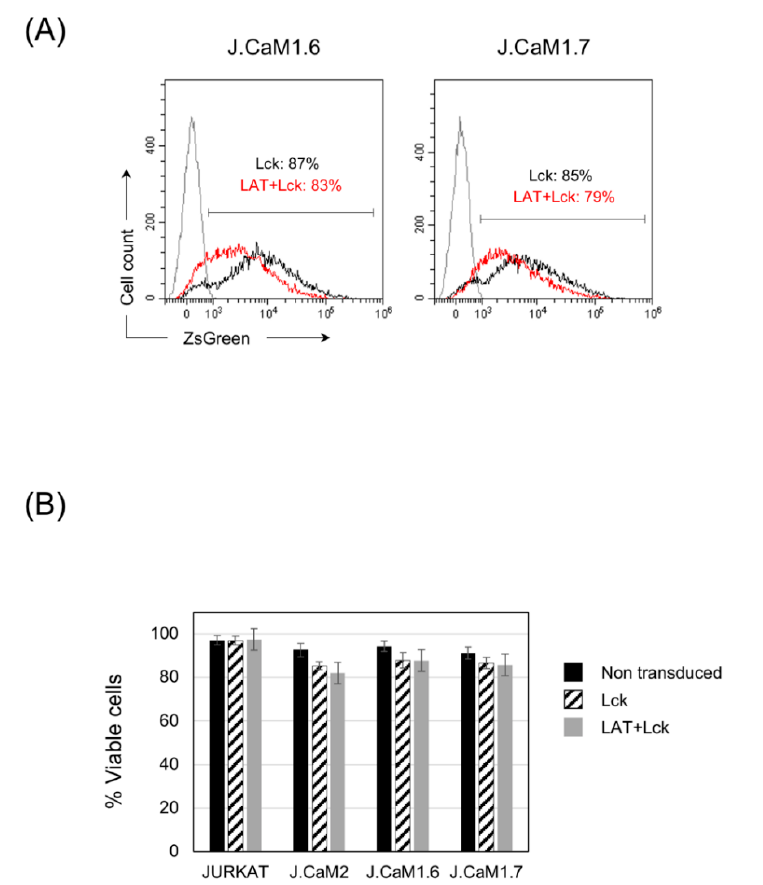
Figure 5. The expression of LAT or Lck does not affect the viability of J.CaM1.6 or J.CaM1.7 cells. ( A ) 72 h after lentiviral transduction of J.CaM1.6 or J.CaM1.7 cells with plasmids coding for Lck (black line) or LAT + Lck (red line) the expression of the reporter ZsGreen was determined by flow cytometry. Numbers indicate the percentage of ZsGreen positive cells. Gray line corresponds to non-transduced cells. ( B ) Viability of Jurkat, J.CaM2, J.CaM1.6, or J.CaM1.7 cells was analyzed 72 h after lentiviral transduction with the indicated plasmids using staining with APC labeled annexin V and propidium iodide (PI) and analyzed by FACS. Cell viability was estimated as the percentage of annexin V and PI negative cells. The values presented are the mean values of six experiments. Bars represent the standard error.